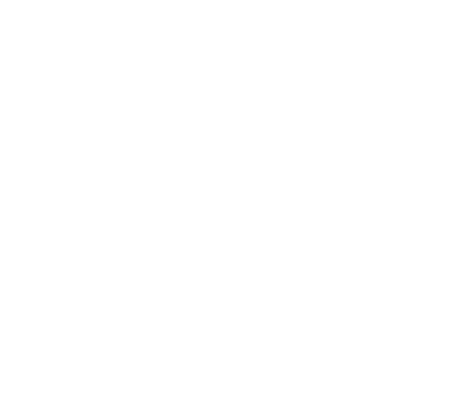
Figure 16. Auto zero procedure starts automatically at power-up to cancel-out most of the residual offset.